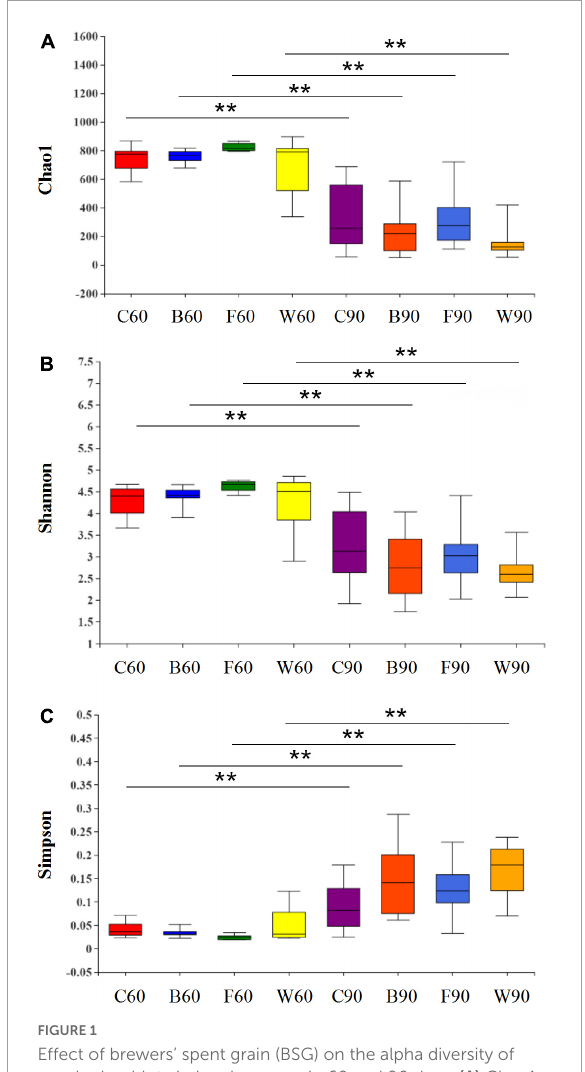
FIGURE1 Effect of brewers’ spent grain (BSG) on the alpha diversity of cecal microbiota in Landes geese in 60 and 90 days. (A) Chao1 index. (B) Shannon index. (C) Simpson index. Symbol “**” indicates the significant difference at P < 0.01. Group C=, control group; Group B, added with 4% BSG in the overfeeding stage (days 61–90); Group F, added with 4% BSG in the rearing stage (days 5–60); Group W, added with 4% BSG in the all stage (days